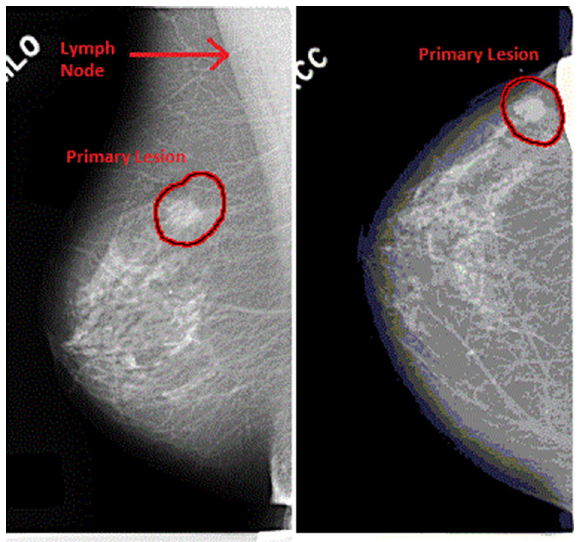
Figure 1. MLO and CC view of a